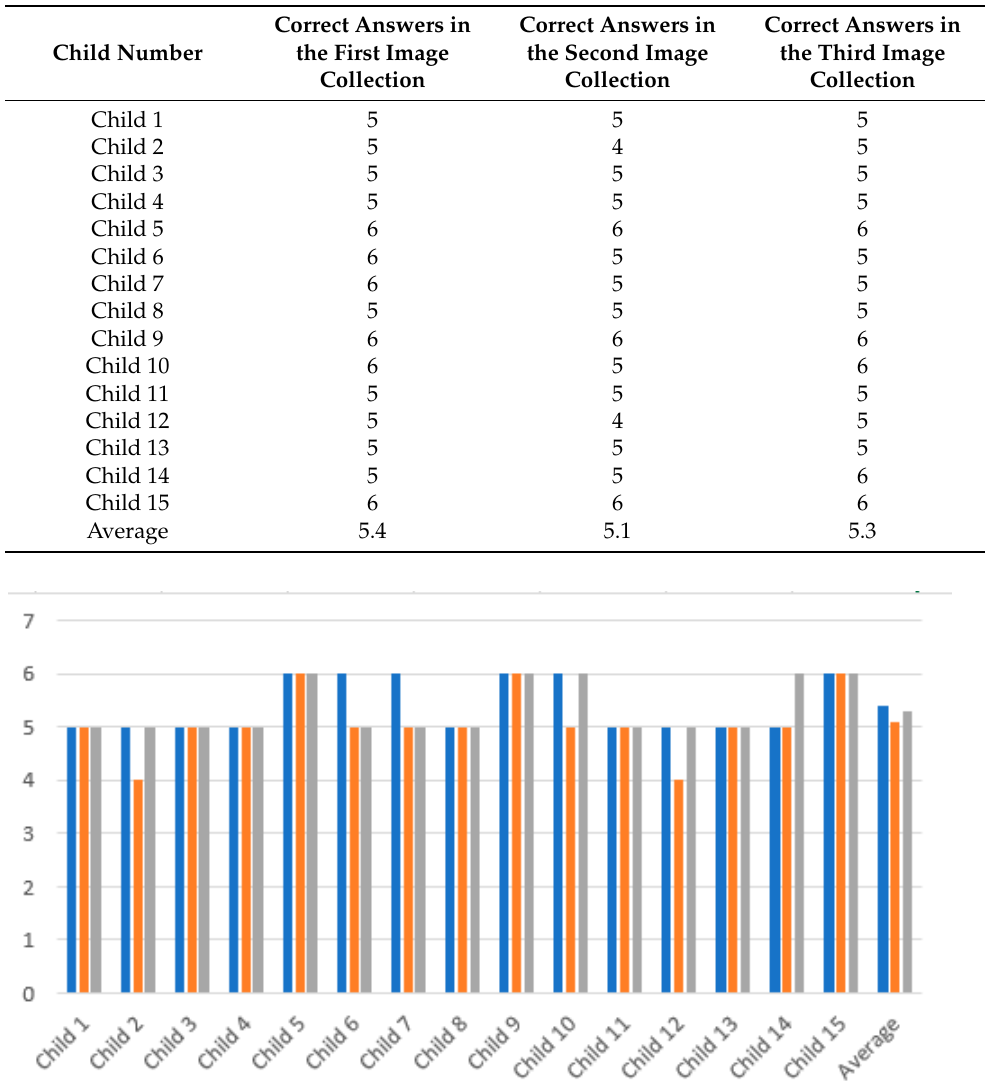
Table 3. Caregivers’ reports on child interaction with three correct answers for the face collections (0–6) in the second day for the TD children.